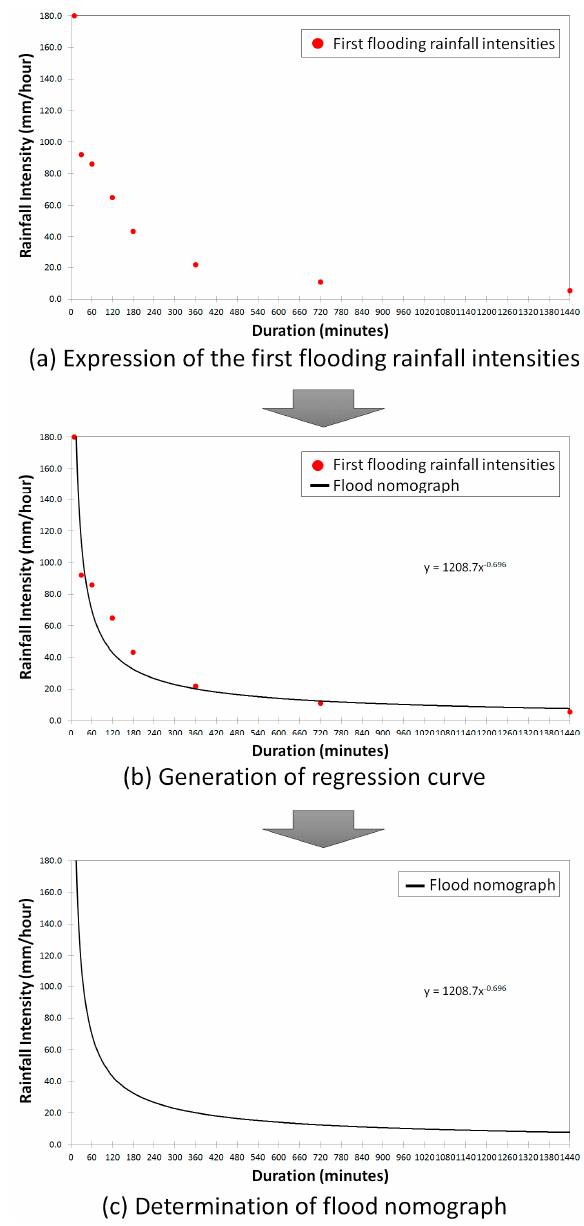
Figure 7. Process for generating the flood nomograph.